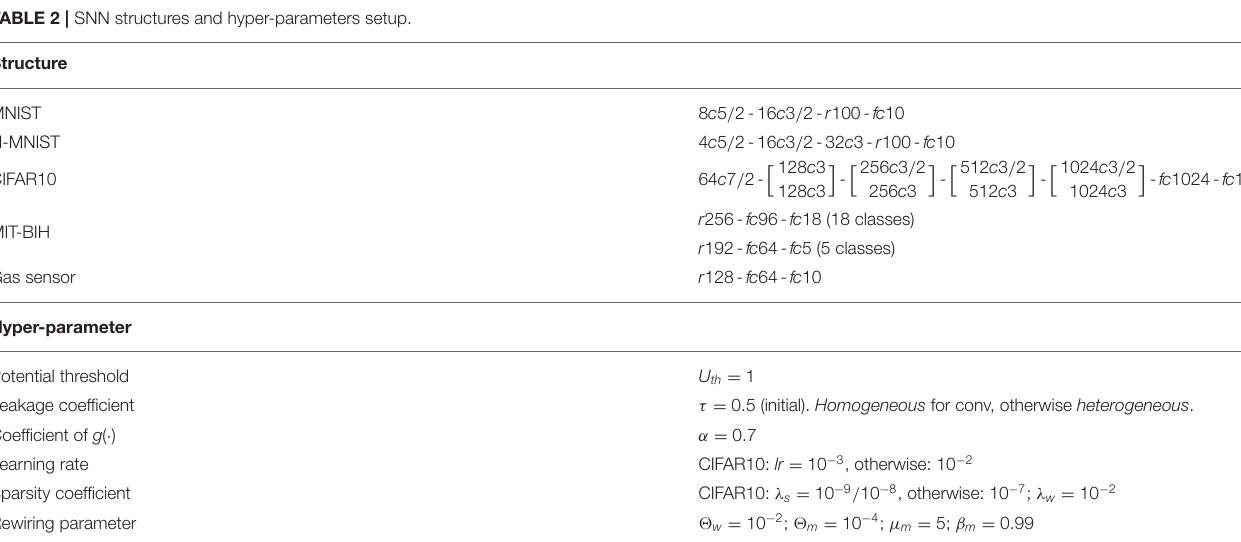
TABLE 2 | SNN structures and hyper-parameters